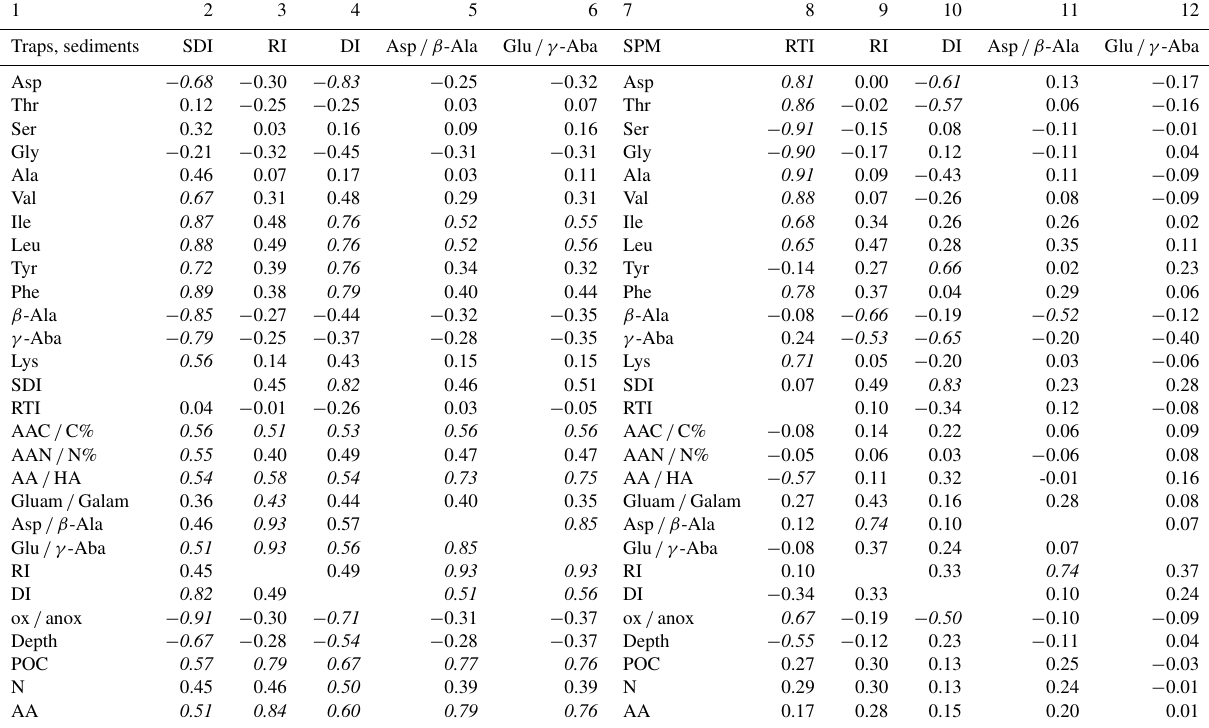
Table 3. Pearson correlation coefficients of the SDI, RI, DI, Asp /β -Ala, and Glu /γ -Aba with selected AA ∗ , the RTI, AAC / C, AAN / N, AA ratios and degradation indices, water depth (Depth), POC and TN contents (%), and AA concentrations (nmolg − 1 ) in sediment trap and sediment samples (columns 2–6). Pearson correlation coefficients of the RTI, RI, DI, Asp /β -Ala and Glu /γ -Aba with selected AA, SDI, AAC / C, AAN / N, AA ratios and degradation indices, water depth (Depth), POC and TN contents (%), and AA concentrations (nmolg − 1 ) in SPM samples (columns 8–12). Italics indicate strong